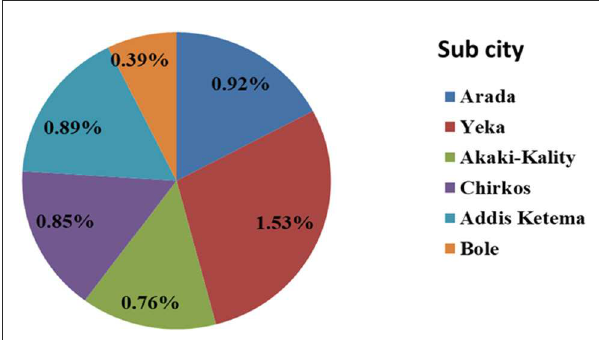
FIGURE1 Prevalence of bacteriological confirmed PTB among homeless individuals in sub cities of Addis Ababa, Addis Ababa, Ethiopia, 2021.